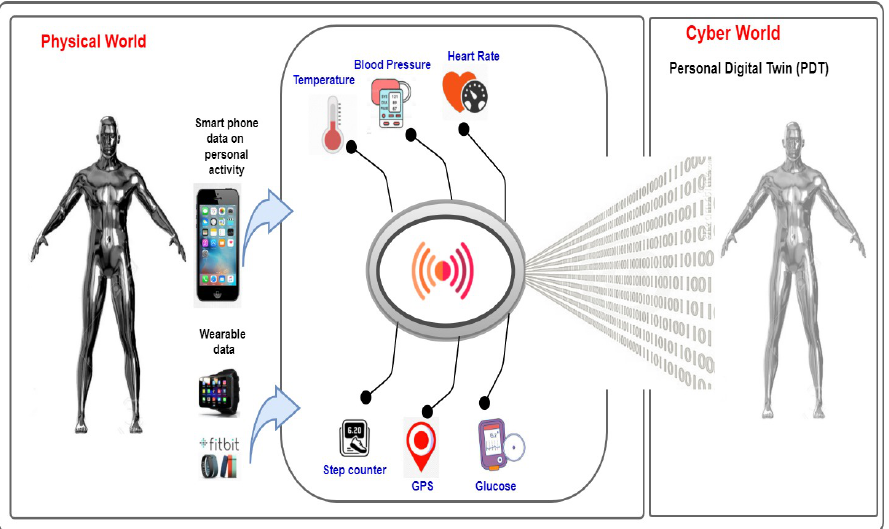
Figure 5. The high level of personal digital twin from a personalised healthcare